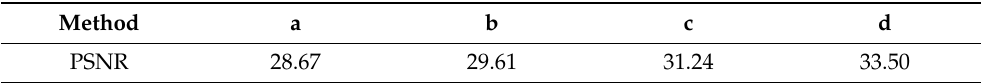
Table 2. The average PSNR(DB) results of different methods on three datasets. (a) Remove three residual blocks. (b) Remove all residual blocks. (c) Remove the preliminary image from the input. (d) Original network.